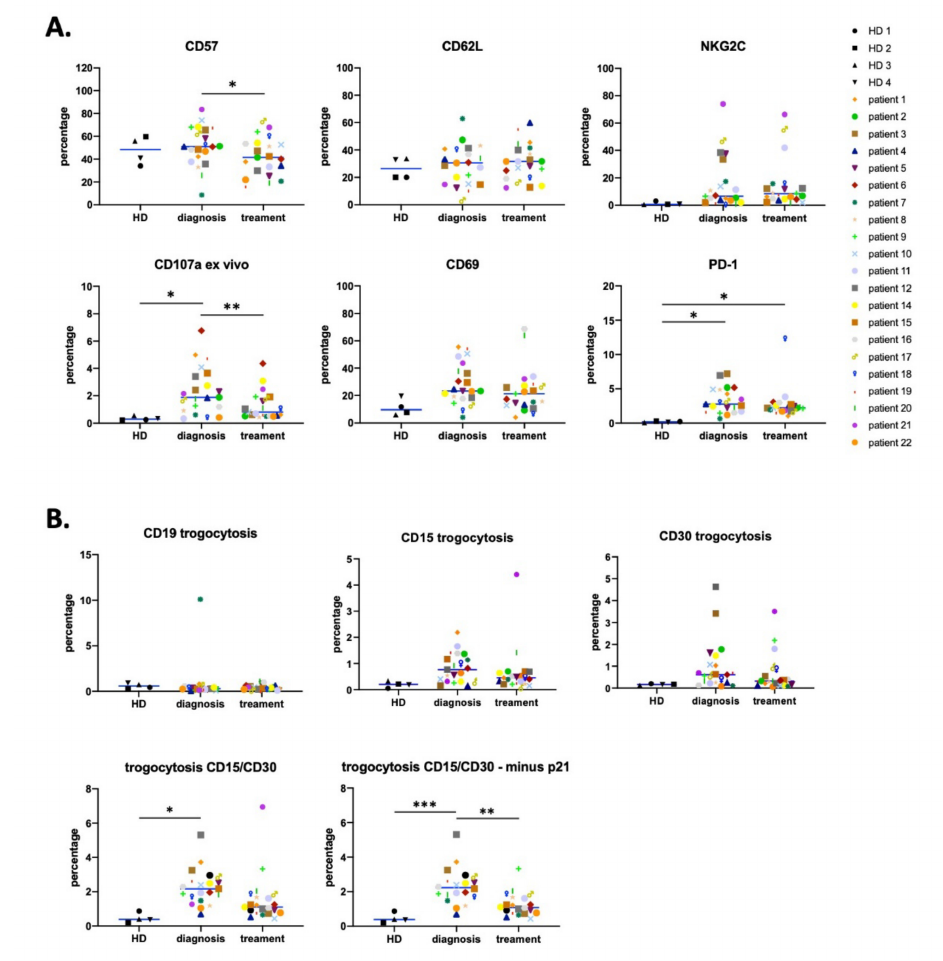
Figure 2. NK cell phenotype analyzed by manual gating. ( A ) Percentage of cells expressing PD-1, CD69, NKG2C, CD57, CD62L, and CD107a (degranulation ex vivo) on NK cells from healthy donors (HD) and from HL patients at diagnosis and after treatment. ( B ) Trogocytosis on tumor surface markers, i.e., CD19 (negative control), CD15, and CD30 (Reed Sternberg cells (RS) markers) by NK cell before and after treatment. In the bottom left graph, we represented NK cells expressing CD15 and / or CD30. The right graph represents the same but excluding patient 21, who was HIV + . Statistical significance between HD versus patients were determined by one-way ANOVA (Dunnett’s correction), “diagnosis” versus “after treatment” for each patient was compared by paired t-test, n = 21, * p ≤ 0.05, ** p ≤ 0.01, and *** p ≤